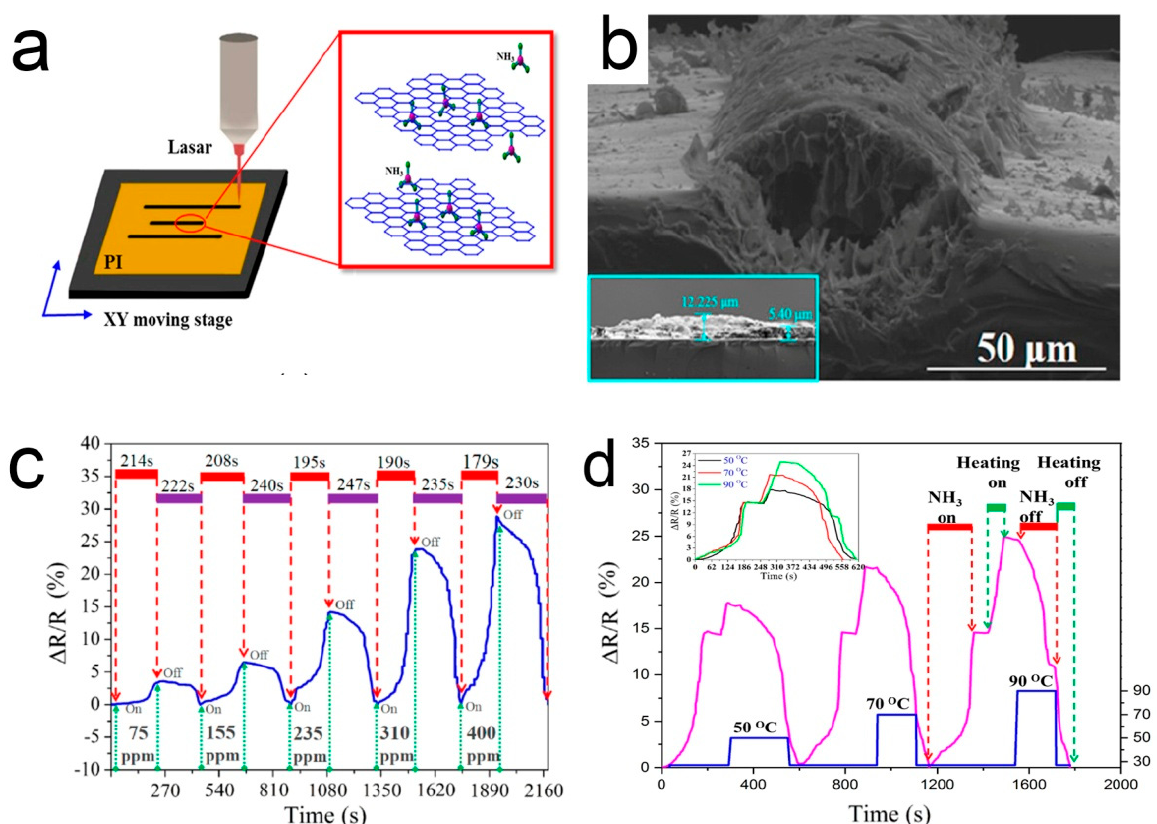
Figure 7. ( a ) A diagram of laser direct writing; ( b ) SEM side view image of the laser-irradiated PI; ( c ) The real-time response/recovery behaviors of the sensor; ( d ) The normalized real-time response/recovery behaviors of the sensor [121].